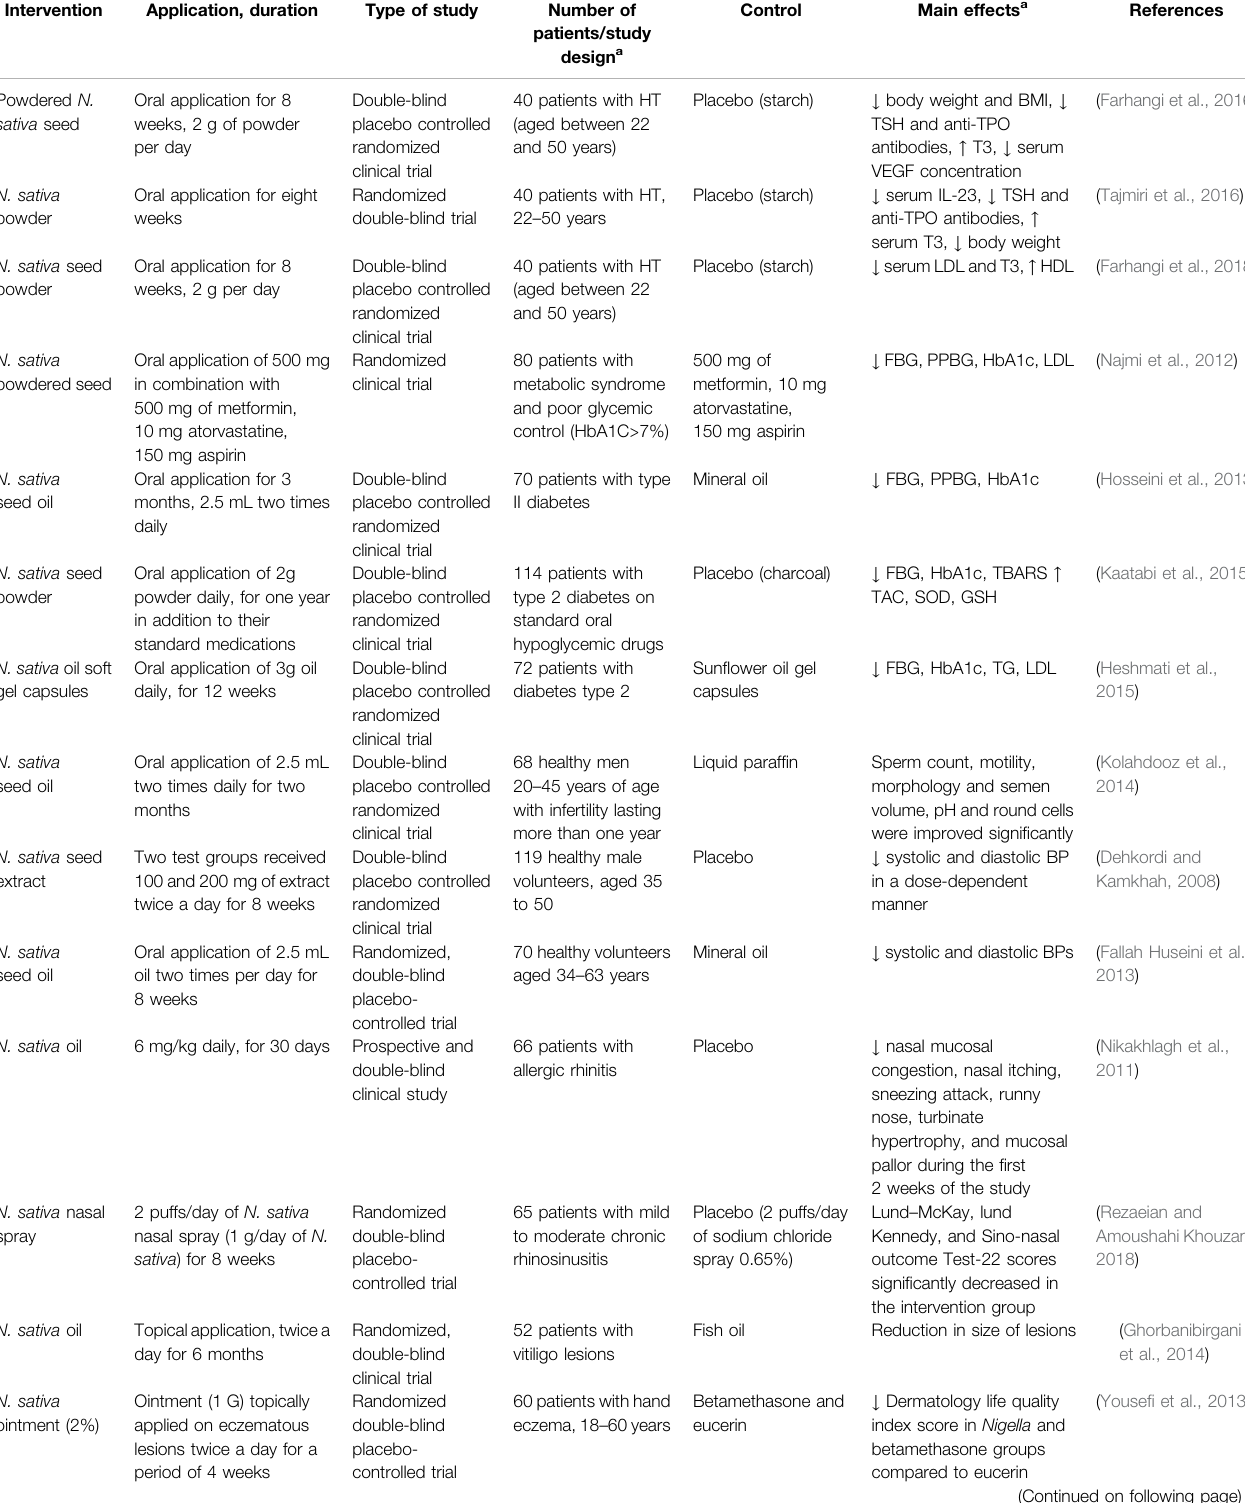
TABLE 4 | Clinical trials on effect of Nigella sativa to various system disorders, diseases and conditions.